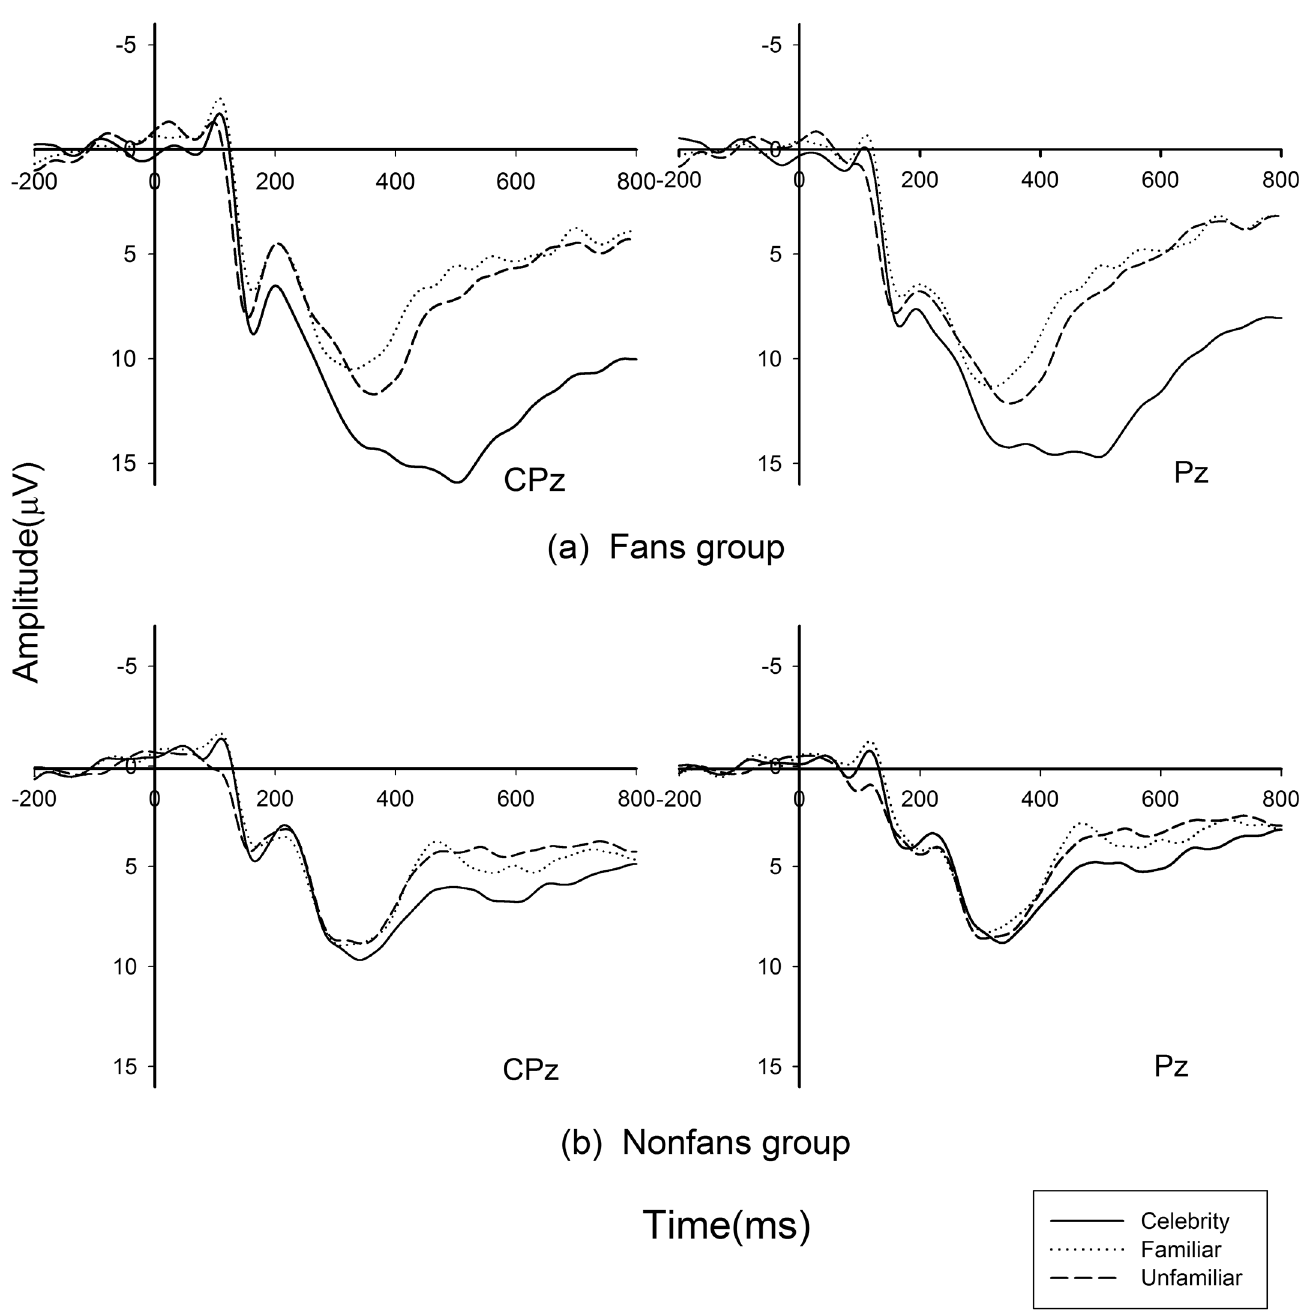
Fig 2. P300 results. Grand average ERP waveforms from channels CPz and Pz, which stand for the selected six electrodes as a function of the three conditions (celebrity, familiar person, and unfamiliar person) for fans (a) and non-fans (b)